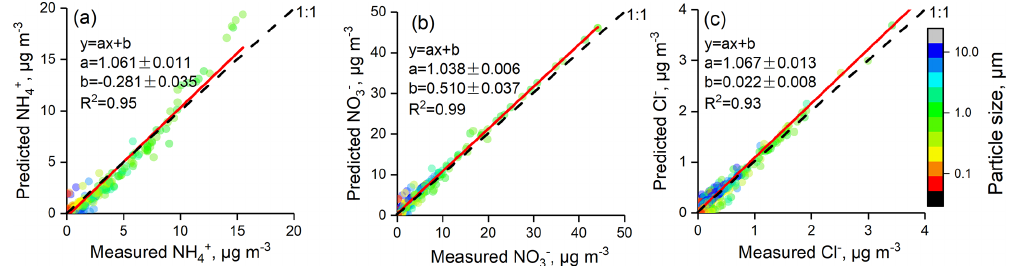
Figure 3. Comparisons of predicted and measured NH +